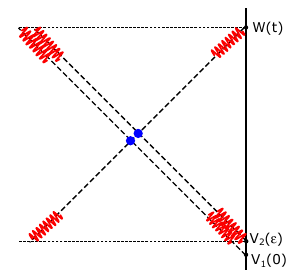
Figure 4 . Shockwave interaction between two infalling modes and one outgoing